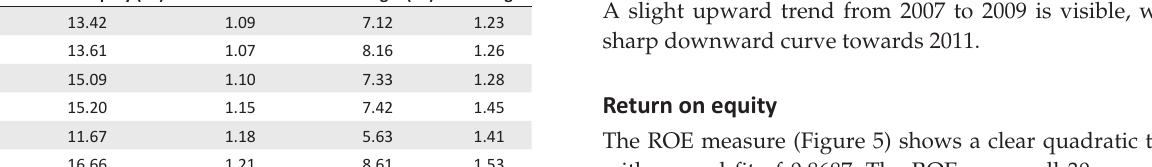
TABLE 3: Company financial performance (standard deviation). Year Return on equity ( % ) Asset